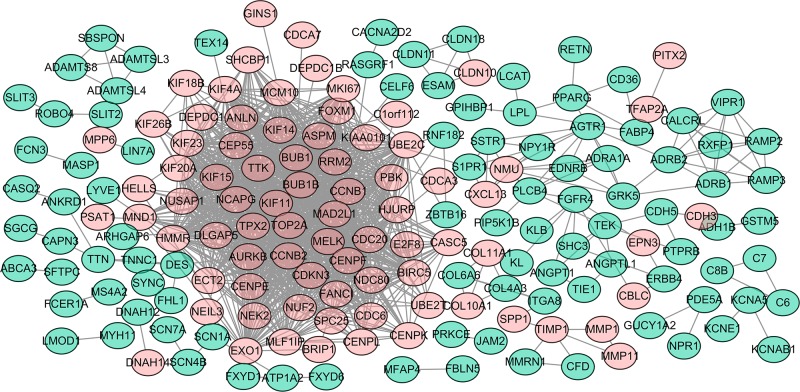
The PPI network.